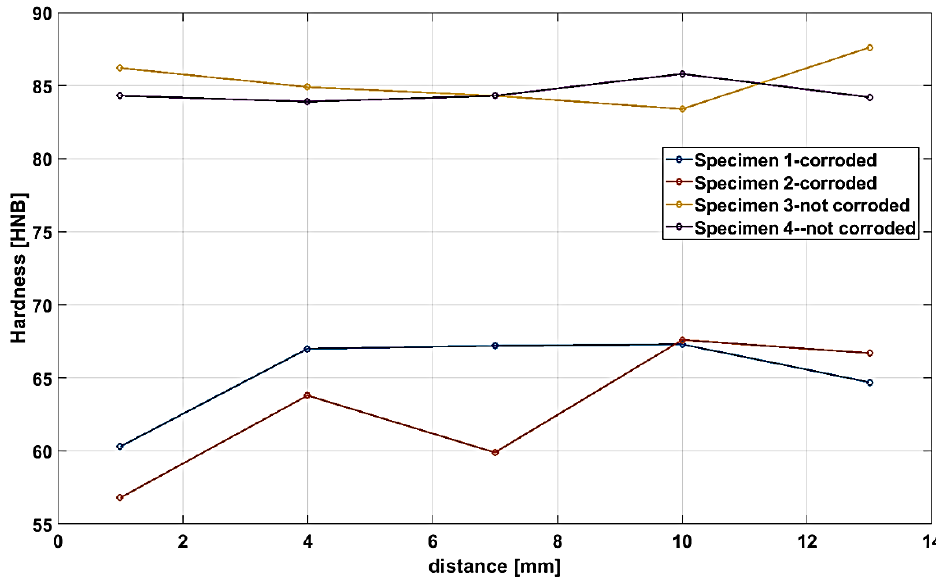
Figure 10. Microhardness of the specimens close and far from the failure region.